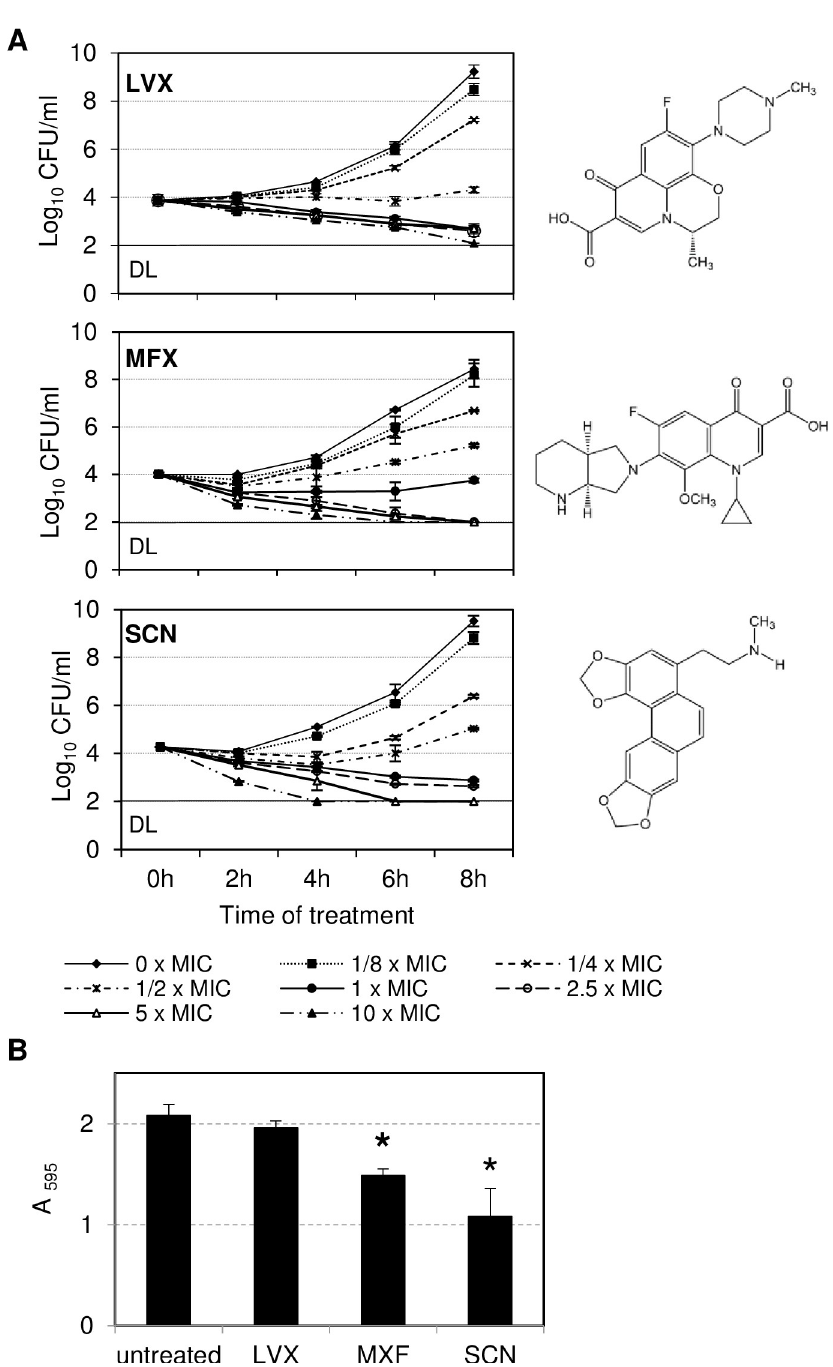
Fig 1. Bactericidal activity of drugs against strain S . pneumoniae R6. (A) Planktonic bacteria killing-curves in the absence or presence of the indicated drugs, which chemical structures are showed on the right. DL, detection limit (B) Inhibition of 6h-biofilm treated with 5 × MIC for 24 h, quantified by crystal violet staining. The results are the mean ± SD of two (A) and three (B) independent experiments. � , P < 0.05 versus untreated.